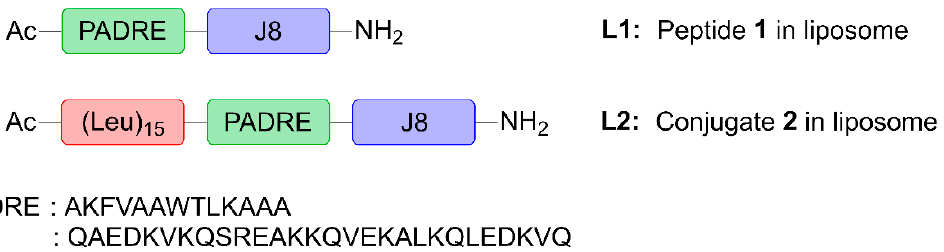
Figure 1. The structures of peptide 1 and polyleucine conjugate 2 , which were encapsulated into liposome delivery systems, L1 and L2 .